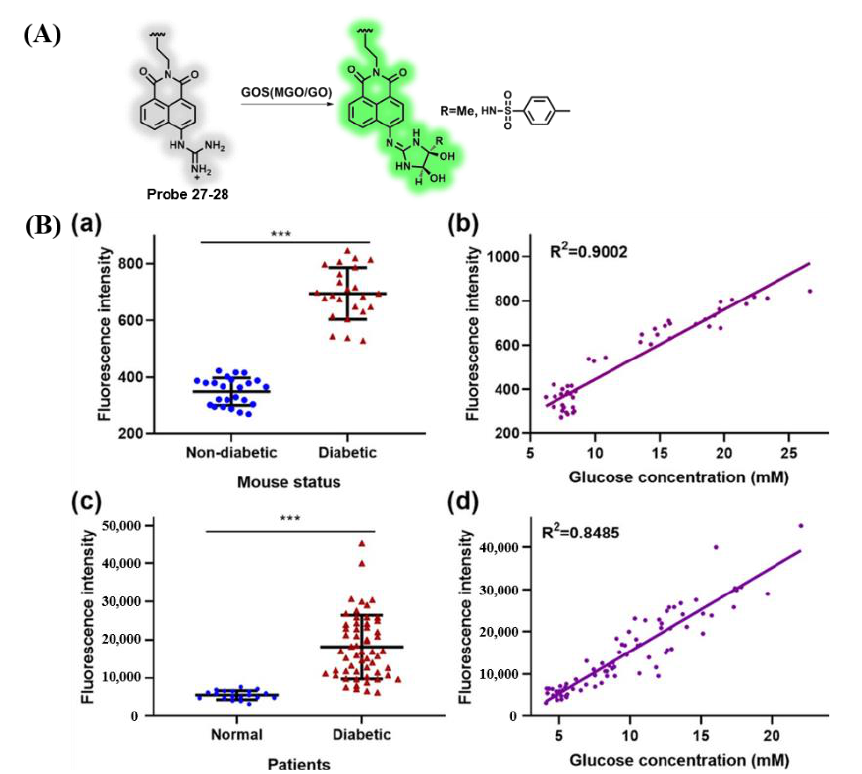
Figure 23. ( A ) Imaging mechanism of probe 27–28 ; ( B ) detection of labile GOS in the serum of diabetic mouse models using probe 28 ; ( Ba ) fluorescence intensity of probe 28 in 100 µ L of serum collected from nondiabetic and diabetic male ion cyclotron resonance (ICR) mice; ( Bb ) correlation between the fluorescence intensities and blood glucose concentrations in the serum from both nondiabetic and diabetic male ICR mice; ( Bc ) fluorescence intensity of probe 28 in 100 µ L of serum collected from patients with diagnosis of diabetes or not; ( Bd ) correlation between the fluorescence intensities and blood glucose concentrations in the serum collected from normal or diabetic individuals. Conditions: for ( Ba ), λ ex = 425 nm, λ em = 564 nm; for ( Bc ), λ ex = 440 nm, λ em = 540 ± 25 nm. *** p < 0.0001. Adapted from Reference [114]. Copyright 2020, American Chemical Society.